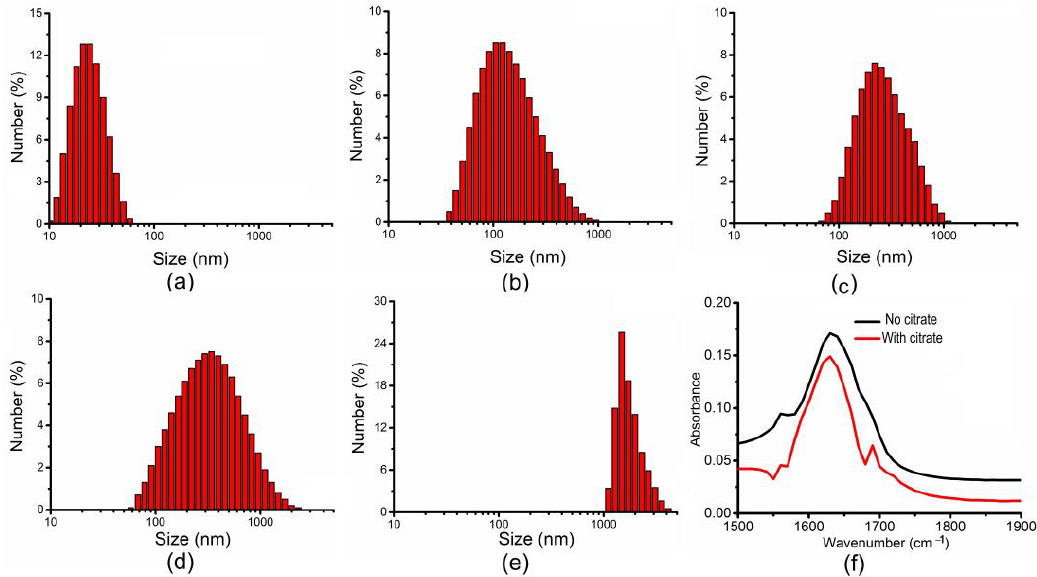
Figure 4. Particle size distribution and FTIR of ICGNPs ( a ) ICGNPs; ( b ) ICGNP – COOH; ( c ) ICGNP – EDC-NHS; ( d ) ICGNP – EDC-NHS-AntiB; ( e ) ICGNP – EDC-NHS-AntiB – Bacteria. ( f ) FTIR absorbance. The ICGNP – COOH with citrate in red curve. The ICGNP without citrate is in the black curve.